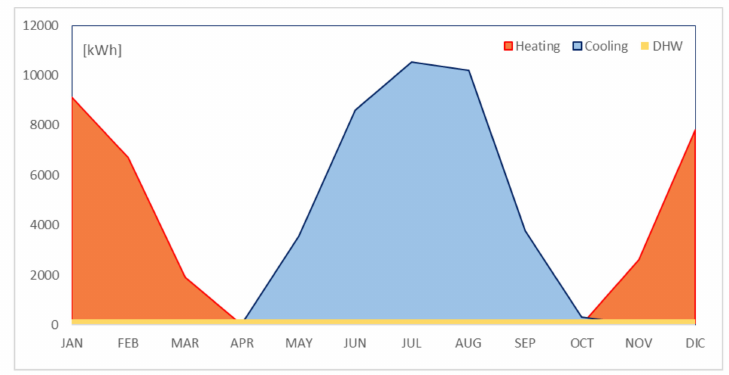
Figure 12. Monthly energy needs for space heating, cooling, and DHW for the case-study building.